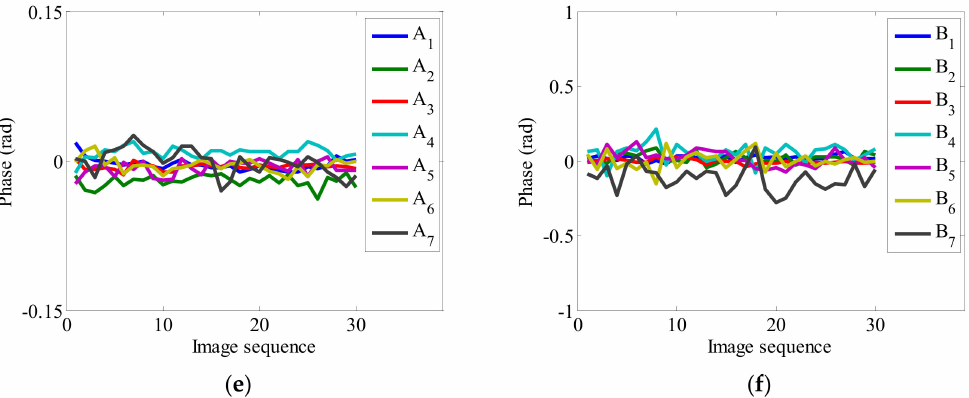
Figure 19. Phase variation curves of seven selected PSs A 1 to A 7 of Group A: ( a ) Before the APC, after the APC ( c ) with the conventional method, and after the APC ( e ) with the improved method. Phase variation curves of another seven PSs B 1 to B 7 of Group B: ( b ) Before the APC, after the APC ( d ) with the conventional method, and after the APC ( f ) with the improved method.